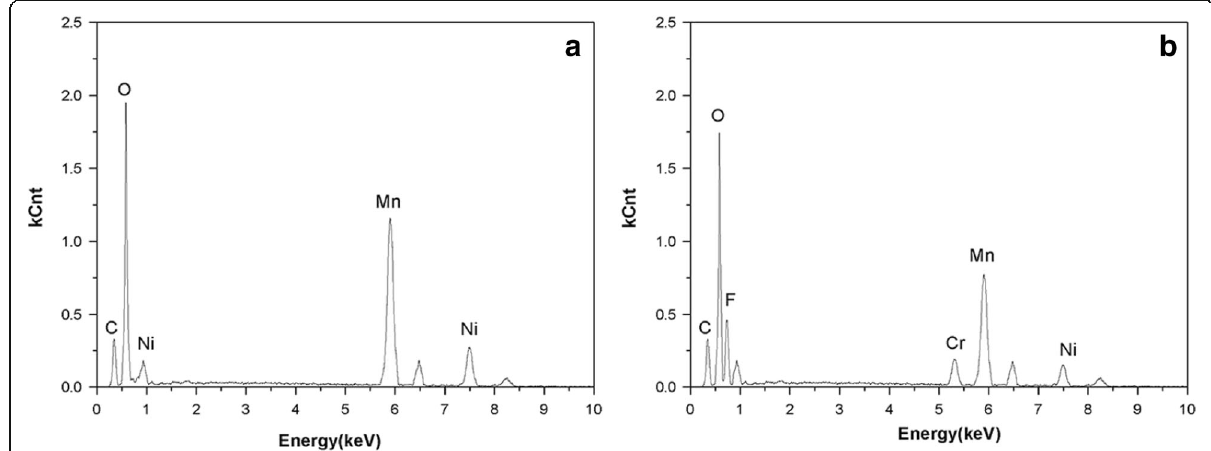
Fig. 3 EDS patterns of LiNi 0.5 Mn 1.5 O 4 ( a ) and LiCr 0.05 Ni 0.475 Mn 1.475 O 3.95 F 0.05 ( b )